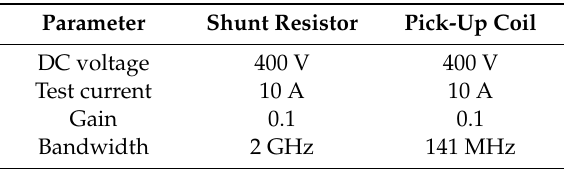
Table 4. DPT test conditions for each current sensor.